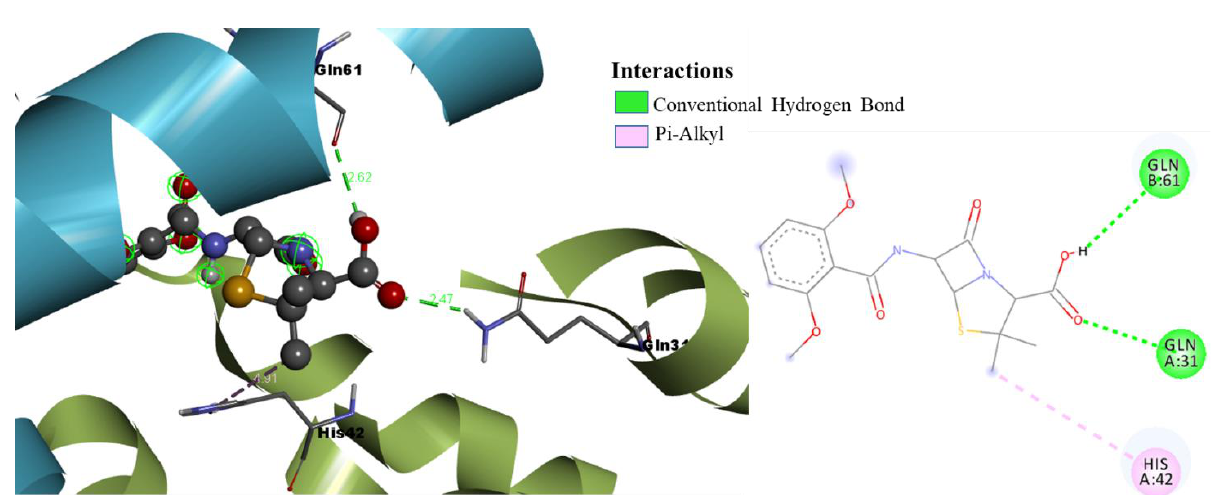
Figure 3. Binding mode conformation and molecular interactions of methicillin in the active site of S. epidermidis TcaR. The left and right figures represent the molecular interactions in 3D and 2D, respectively. The methicillin is shown in the ball-stick model, and the key interacting residues are shown as grey